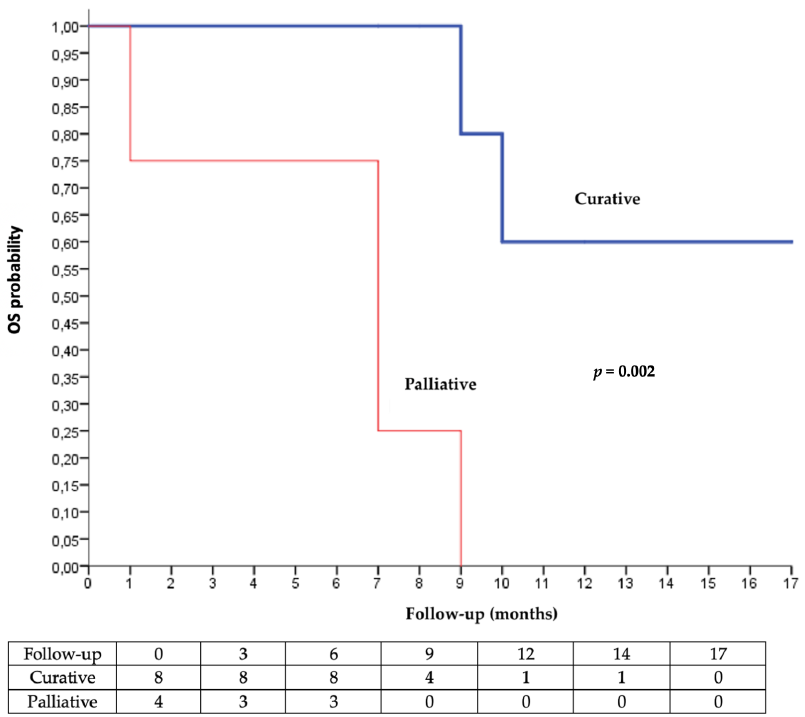
Figure 2. Kaplan–Meier analysis of overall survival according to the intent of radiotherapy (palliative vs.